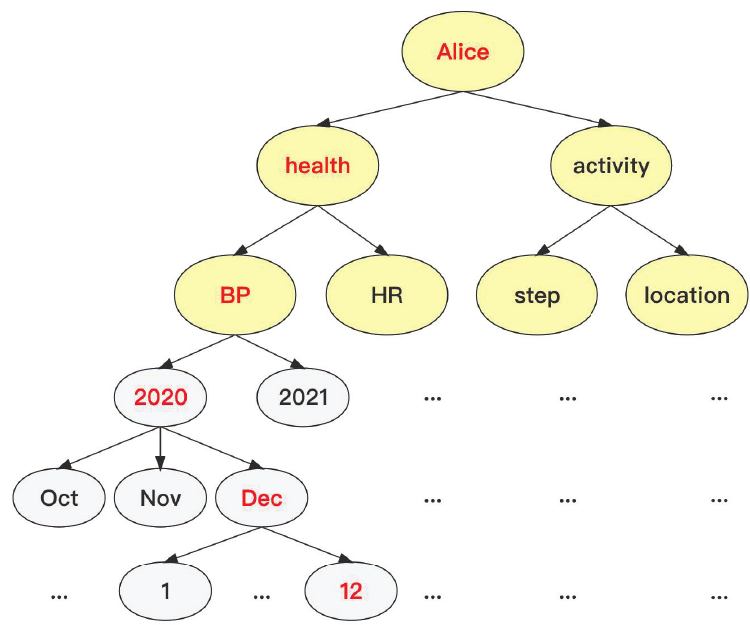
Figure 5. Alice’s